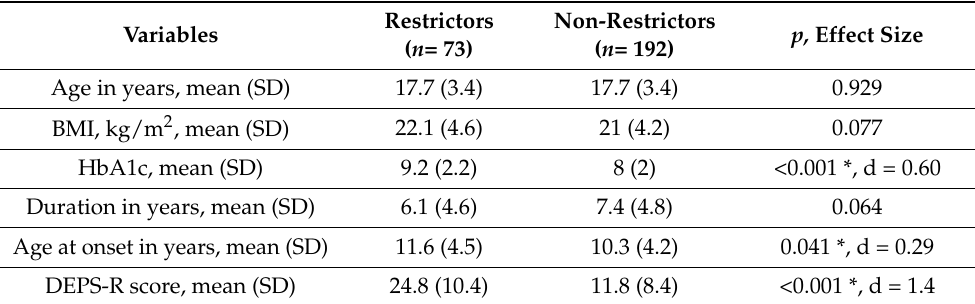
Table 3. Comparison of insulin restrictors and non-restrictors.